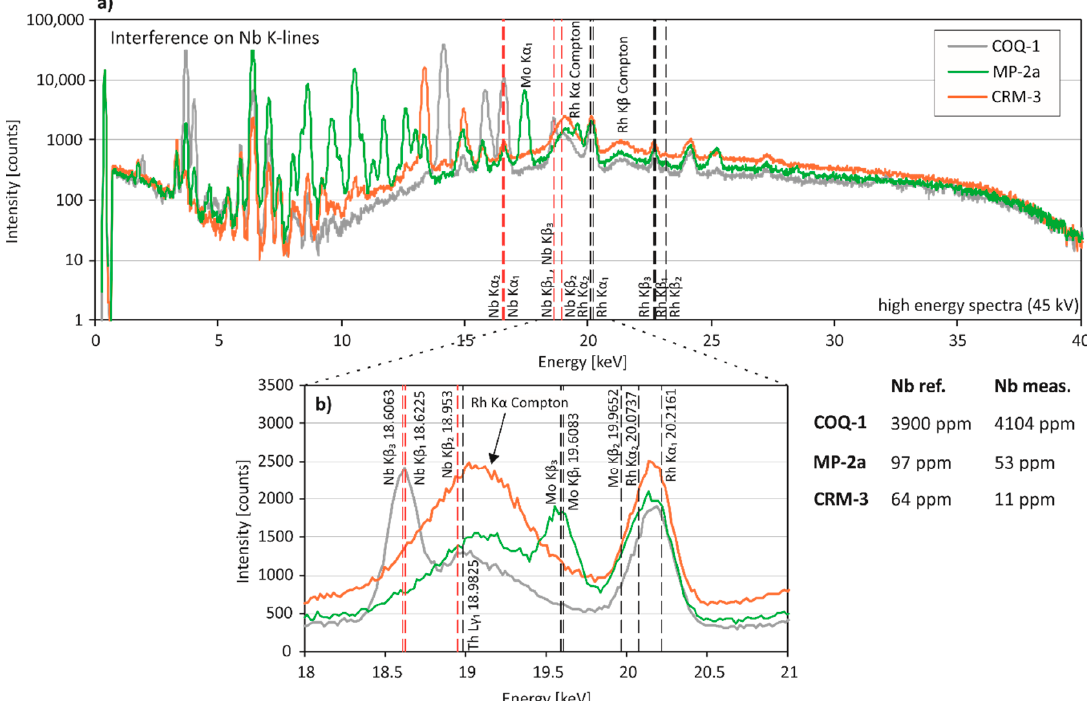
Figure 5. Spectral interferences on Nb. ( a ) Entire energy region (0–40 keV) and ( b ) close up of representative X-ray fluorescence spectra for pXRF measurements of COQ-1, MP-2a and CRM-3. ( b ) Nb K-lines are shown in red. The arrow indicates the Rh K α Compton peak of the X-ray source. Excitation energy of the measurements was 45 kV.